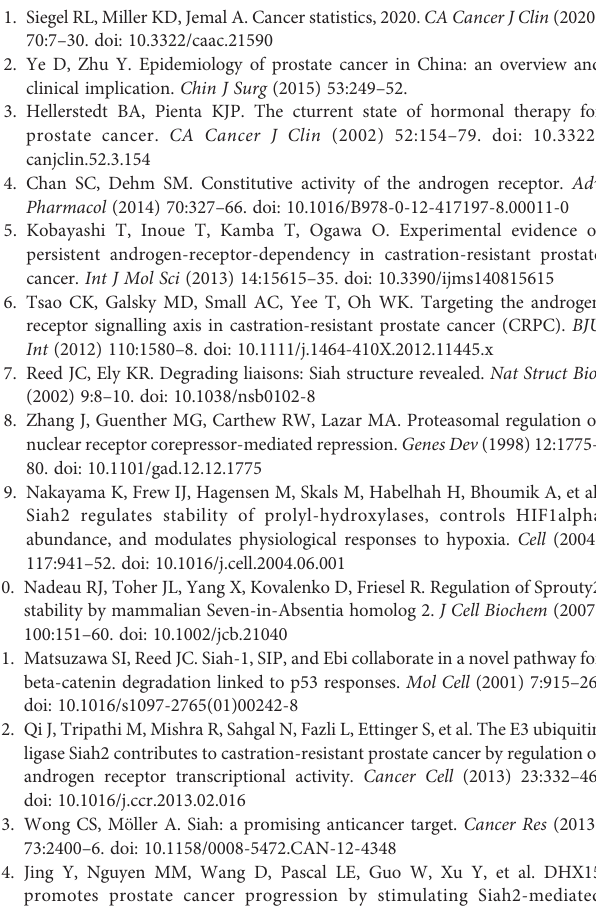
Supplementary Figure 1 | Androgens stabilize Siah2 protein. (A) LNCaP cells were cultured in CS for 24 h, subsequently treated with different dose of DHT or fl utamide (5 m M) as indicated for another 24 h, and AR and Siah2 protein expression were detected by Western blotting. (B) LNCaP and PC3 cells were cultured in CS for 24 h, subsequently treated with 10 nM DHT or vehicle for 24 h. AR and Siah2 protein expression were detected by Western blotting. Supplementary Figure 2 | AR inhibits Siah2 self-ubiquitination and decreases its E3 ligase activity. (A) 293 cells were transfected with Flag-Siah2, GFP-AR and Myc- Spry2 as indicated for 48 h and then treated with cycloheximide (CHX, 50 m g/ml) for 1, 3, 6 h and cell lysates were subjected to Western